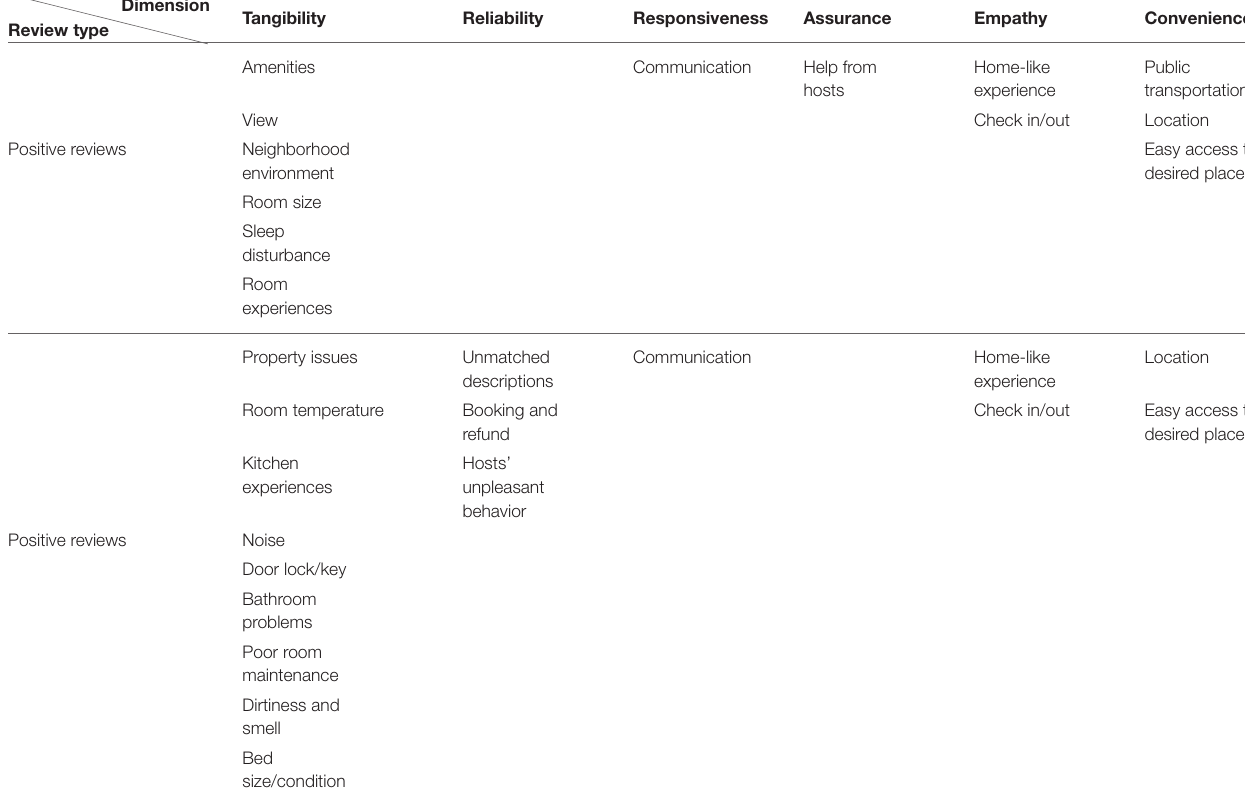
TABLE 4 | Topic classification. Review type